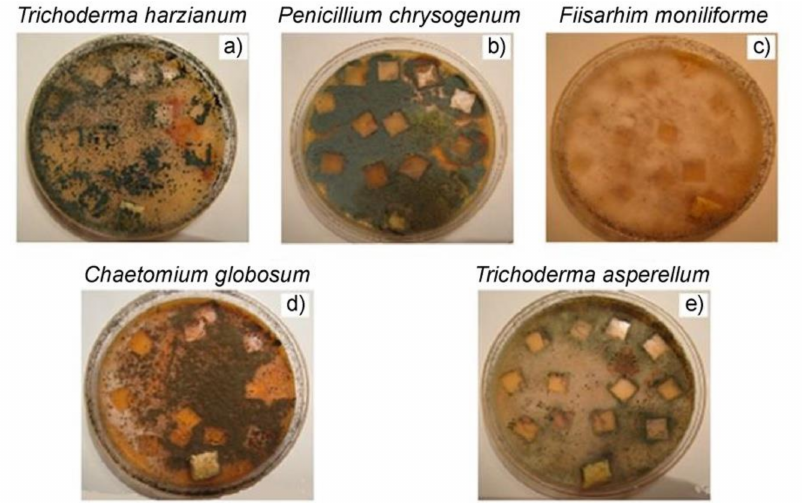
Figure 8. Photographs of composite samples of PE/NR = 70/30 25 days after inoculation with mold fungi ( a ) Trichoderma harzianum Rifai , ( b ) Penicillium chrysogenum Thorn , ( c ) Fiisarhim moniliforme Sheld , ( d ) Chaetomium globosum Kunze , ( e ) Trichoderma asperellum Samuels Lieckf and Nireberg . Adapted from Mastalygina Elena et al.